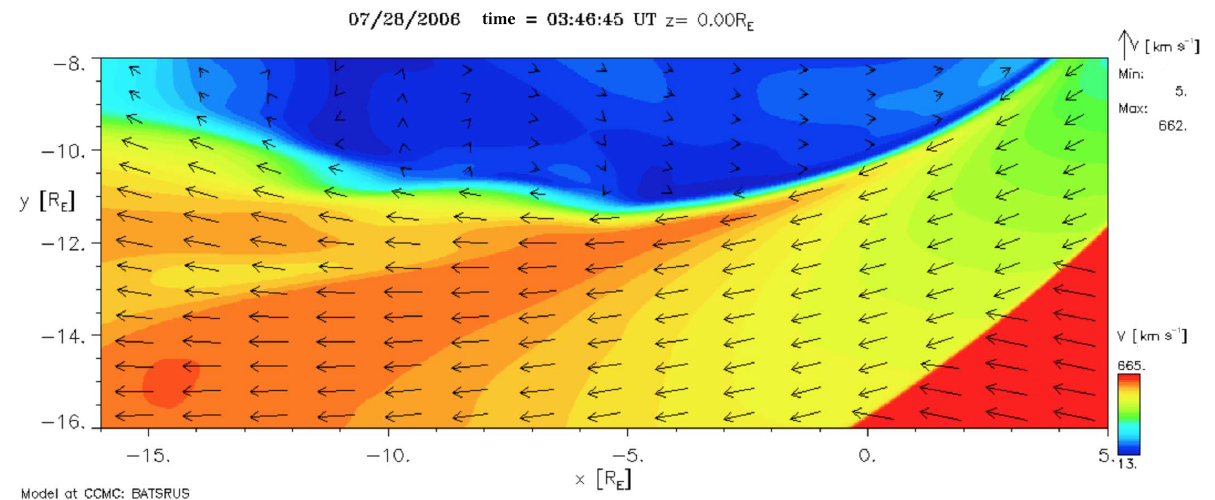
Figure 10. Close-up of the X – Y cut at 03:46UT time step of the simulation where it appears that there no vortices are formed at the boundary. The quantities represented are the same as in Fig. 9. The flow speeds along the boundary are still elevated compared to the flow speed of the solar